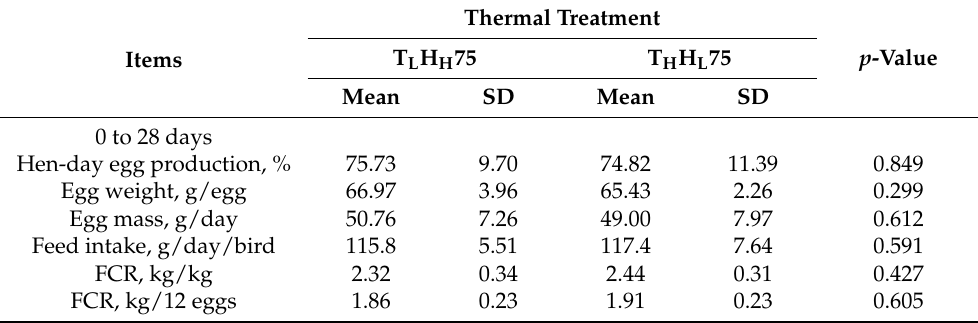
Figure 1. Effect of different ambient temperatures and humidity (same Temperature-Humidity Index) on plasma biochemical parameters. Laying hens were exposed to two ambient temperature conditions (26 ◦ C, 70%; 30 ◦ C, 30%). Error bars indicate the standard deviation of the mean ( n = 10). T L H H 75 = temperature 26 ◦ C; relative humidity 70%; T H H L 75 = temperature 30 ◦ C; relative humidity 30%. ( A ) Total cholesterol (mg × dL − 1 ). ( B ) Triglycerides (mg × dL − 1 ). ( C ) High-density lipoprotein (HDL) cholesterol (mg × dL − 1 ). ( D ) Calcium (mg × dL − 1 ). ( E ) Phosphorus (mg × dL − 1 ). ( F ) Magnesium (mg × dL − 1 ). ( G ) Nitric oxide ( µ M). Table 2. Effect of different ambient temperatures with the same temperature-humidity index (THI = 75) on laying performance of laying hens 1.